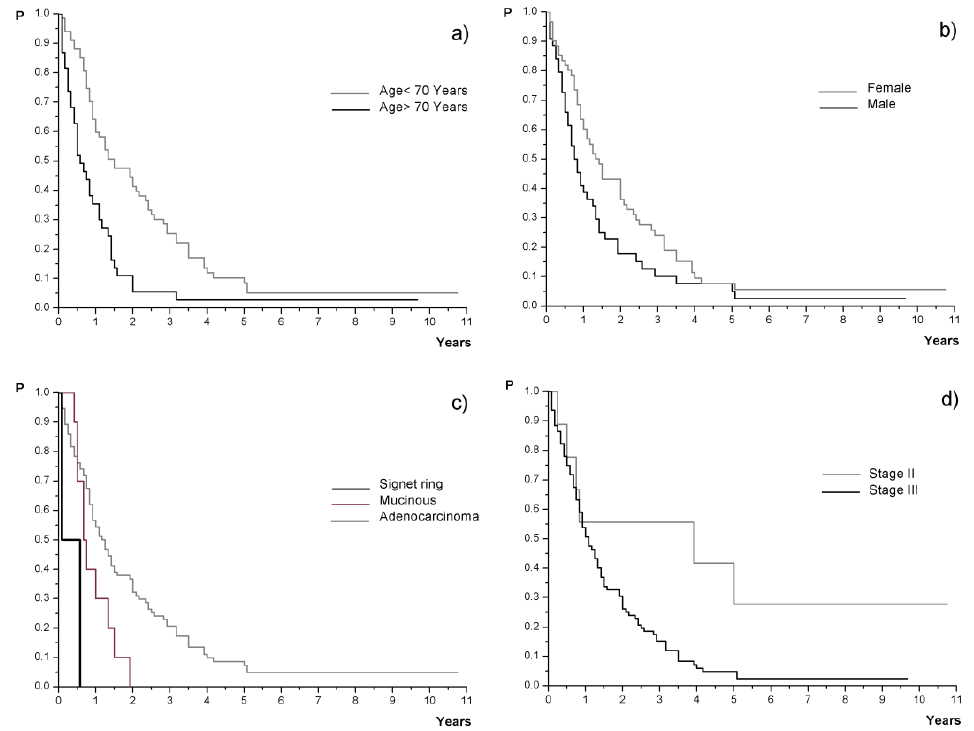
Figure 2. Kaplan–Meier curves for post-recurrence survival according to ( a ) age at diagnosis, p < 0.01; ( b ) gender, p < 0.05; ( c ) histology, p < 0.01; ( d ) clinical stage at diagnosis, p < 0.05.